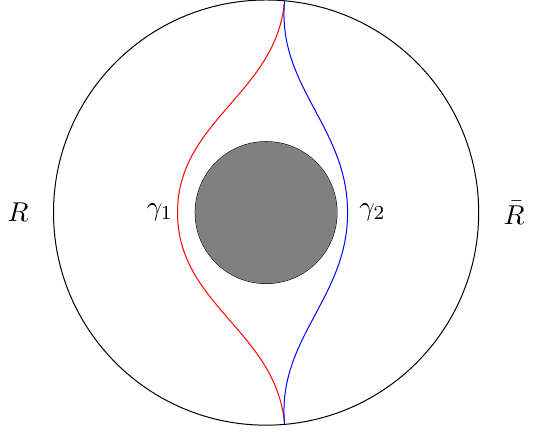
Figure 8 . Two competing candidate RT surfaces in the BTZ black hole